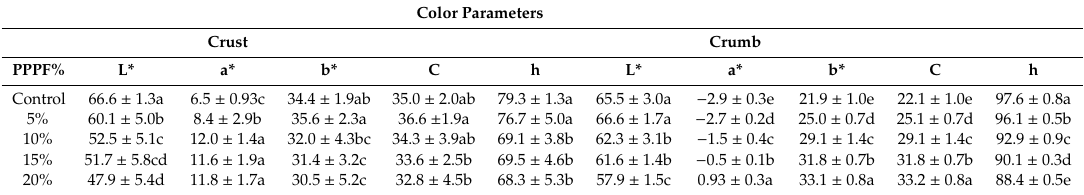
Table 6. Color parameters in bread samples for crust and crumb. Color Parameters Crust